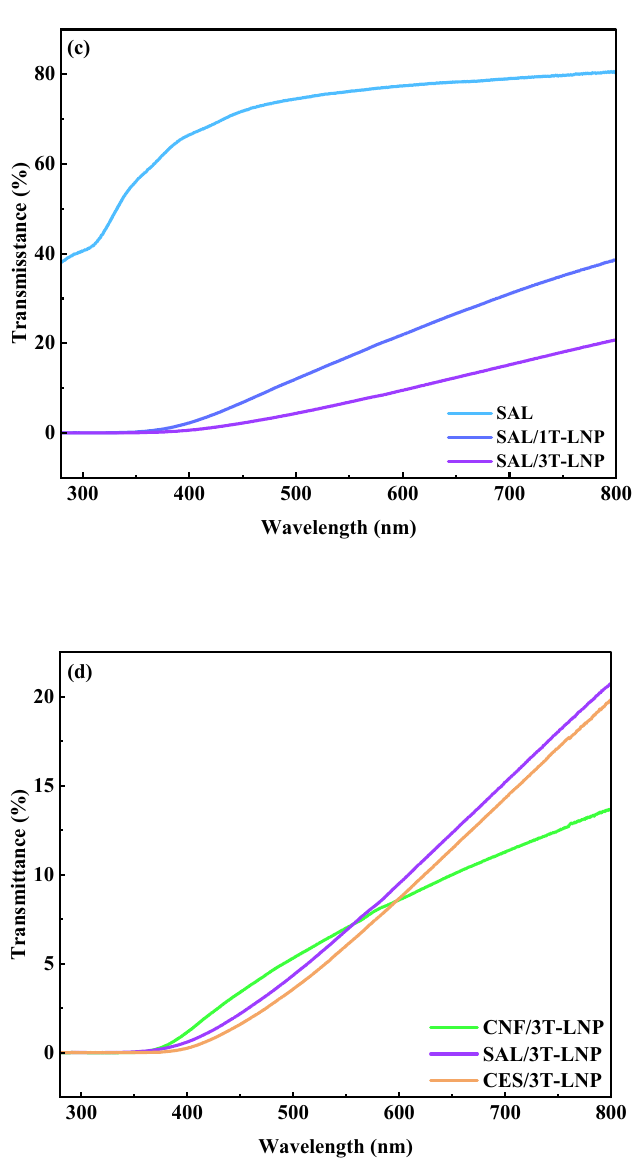
Figure 8. UV–vis spectra of ( a ) CNF, ( b ) CES, ( c ) SAL based composite materials with different amount of LNP; ( d ) UV–vis spectra comparison of the binary composite films. Table 5. Anti-ultraviolet performance comparison of composite films from historical reference.